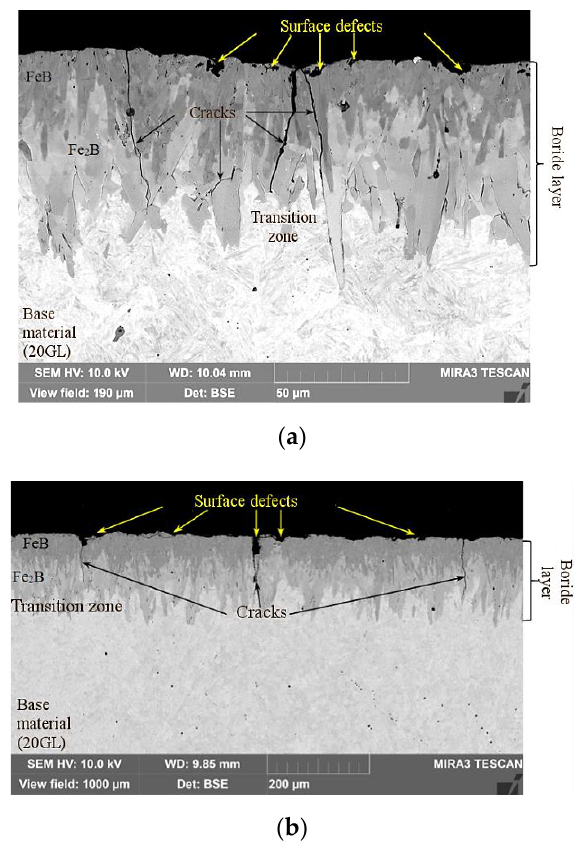
Figure 6. Picture of cross-sectional metallographic specimen of steel 20GL sample with boriding of type II after penetrant testing of surface defects: ( a ) boriding of type I; ( b ) boriding of type II.